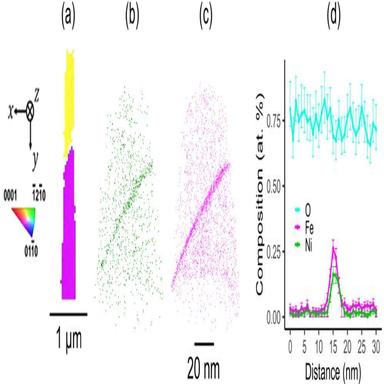
(a) TKD map of Ti-7Al + 2500 wppm O sample that contains a grain boundary. APT atom maps showing the segregation of (b) Ni and (c) Fe to a grain boundary. (d) One-dimensional compositional profile of O, Fe, and Ni through a region of the grain boudary.